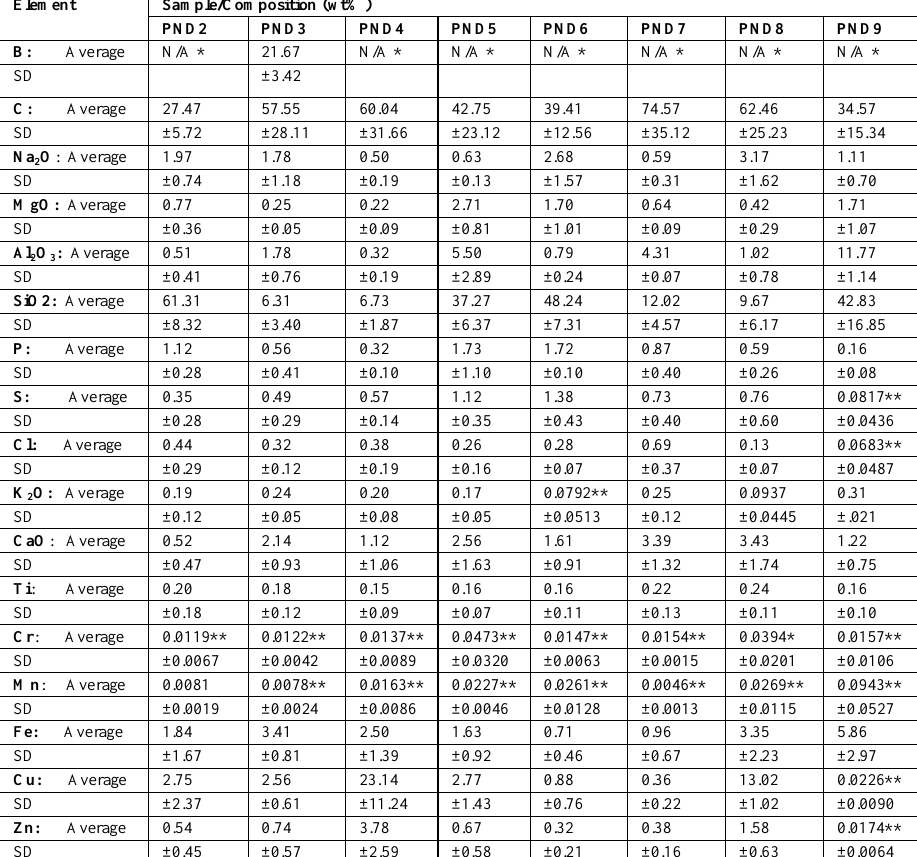
Table 1. Composition of Phra Kru Nadune amulets analyzed using SEM-EDS and PIXE.